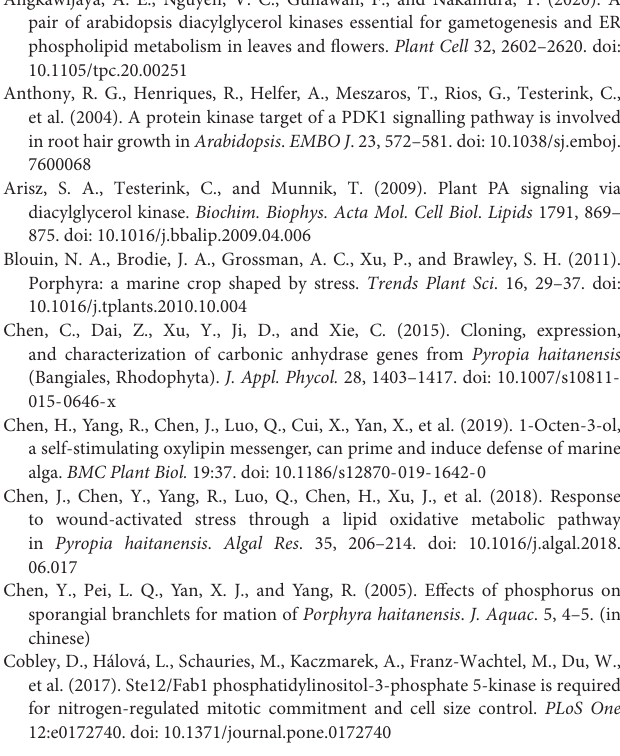
Supplementary Table 7 | The nucleotide and amino acid sequence information of PhDGK1 . Red represented the initiator and terminator codons, green represented the primers